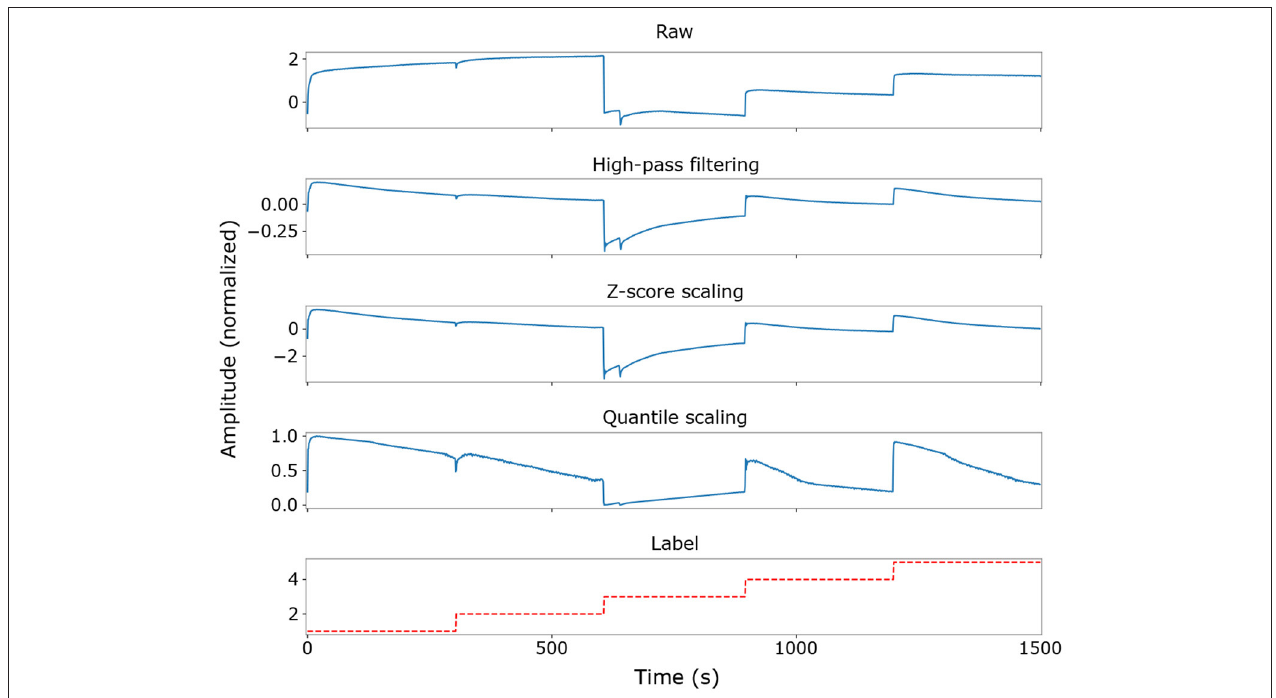
FIGURE 3 | Dataset preprocessing transforms when using a high-pass filter with a cutoff frequency of 0.5mHz, shown for the first 1,500 measurements in the dataset for a single ISFET sensor channel (Cl − ). Note the nonlinear enhancement of near-zero signals by the quantile scaler. Signal traces are not continuous in time everywhere due to the removal of invalid measurements and edge discontinuities between labels.